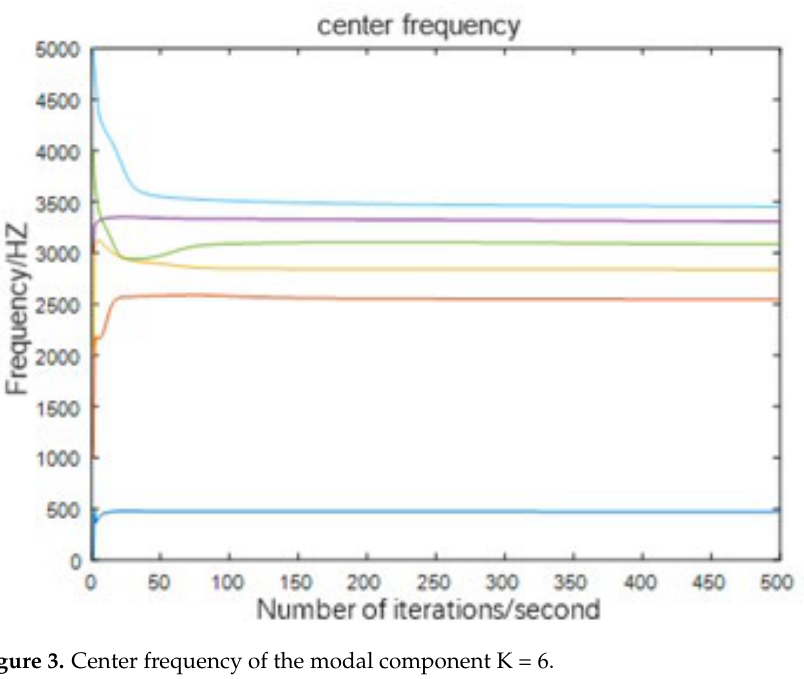
Figure 3. Center frequency of the modal component K = 6.